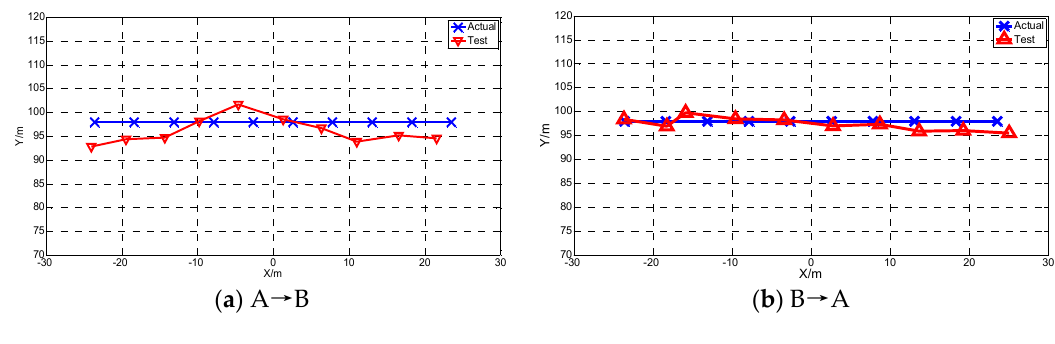
Figure 13. Actual and tested path of source.